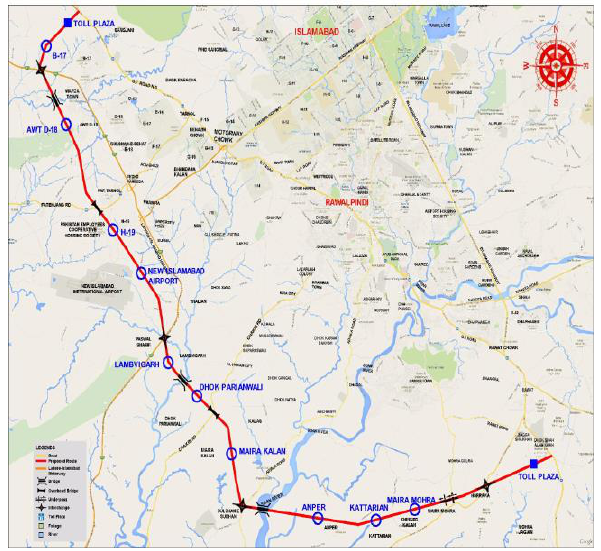
Figure 2: Alignment # 1 for the proposed Rawalpindi Bypass (60